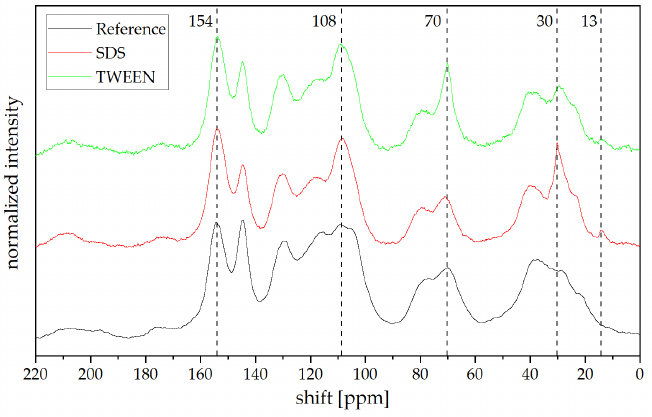
Figure 7. 13 C CP MAS NMR spectra of reference foam, SDS 4, and TWEEN 10 foams.